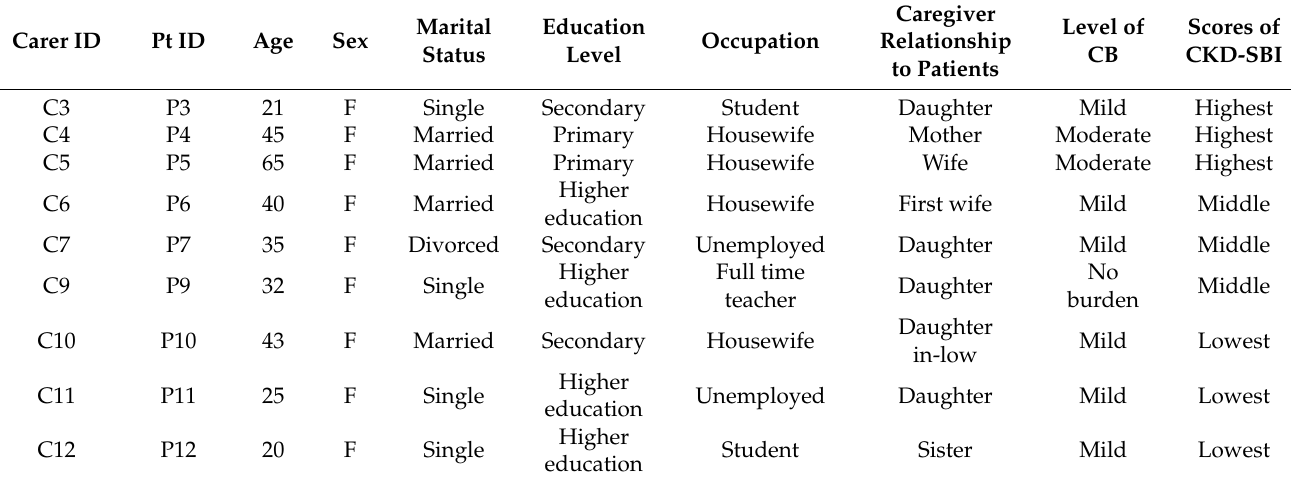
Table 4. Demographic information for caregivers who were